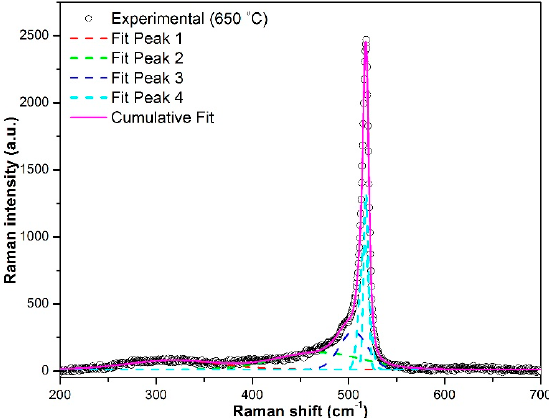
Figure 9. Raman spectra of furnace annealed PECVD silicon thin film at 650 °C. The experimental data is shown with symbol (o), solid magenta color represents the cumulative Gaussian fit, and the remaining four dotted curves are deconvoluted Gaussian peaks.